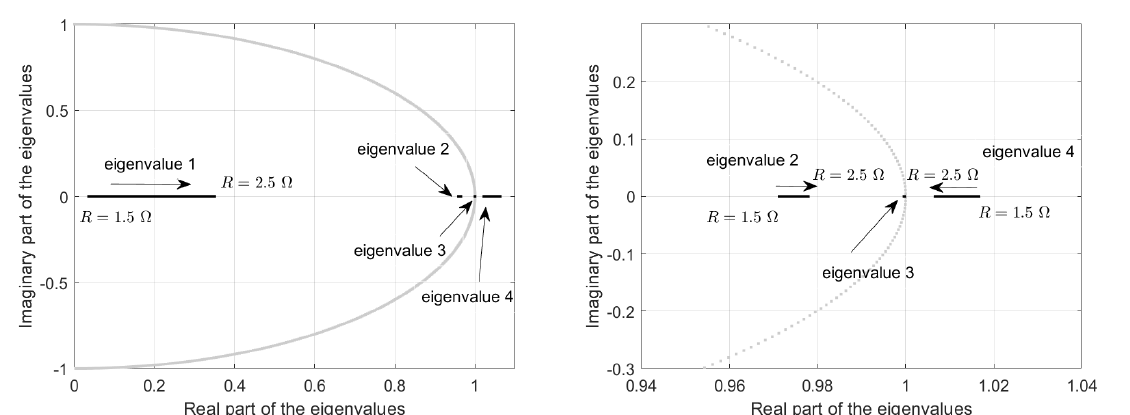
Figure 9. Locus of the eigenvalues of the monodromy matrix in faulty switching case h 3 = 0, h 1 = h 2 = 1, when R varies.